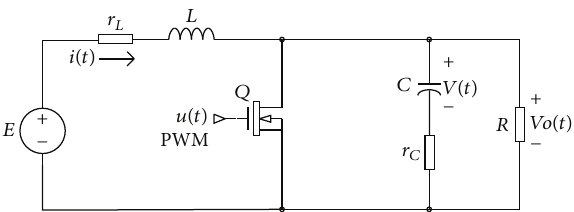
Figure 1: The boost converter circuit having parasitic resistances 𝑟 𝐿 and 𝑟 𝐶